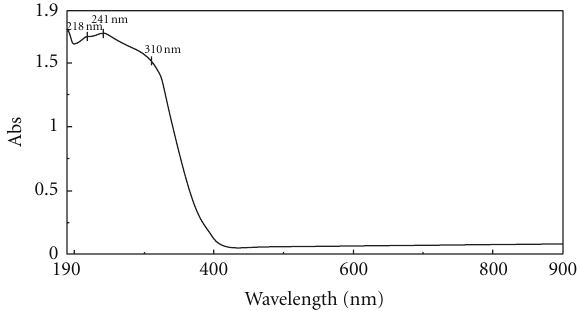
Figure 7: Uv-vis absorbance spectra of TiO 2 photocatalyst thin